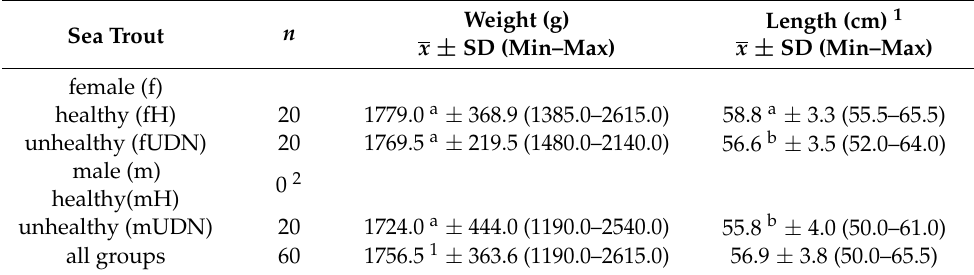
Table 1. Morphometric data of sea trout ( Salmo trutta m. trutta L.) from the river